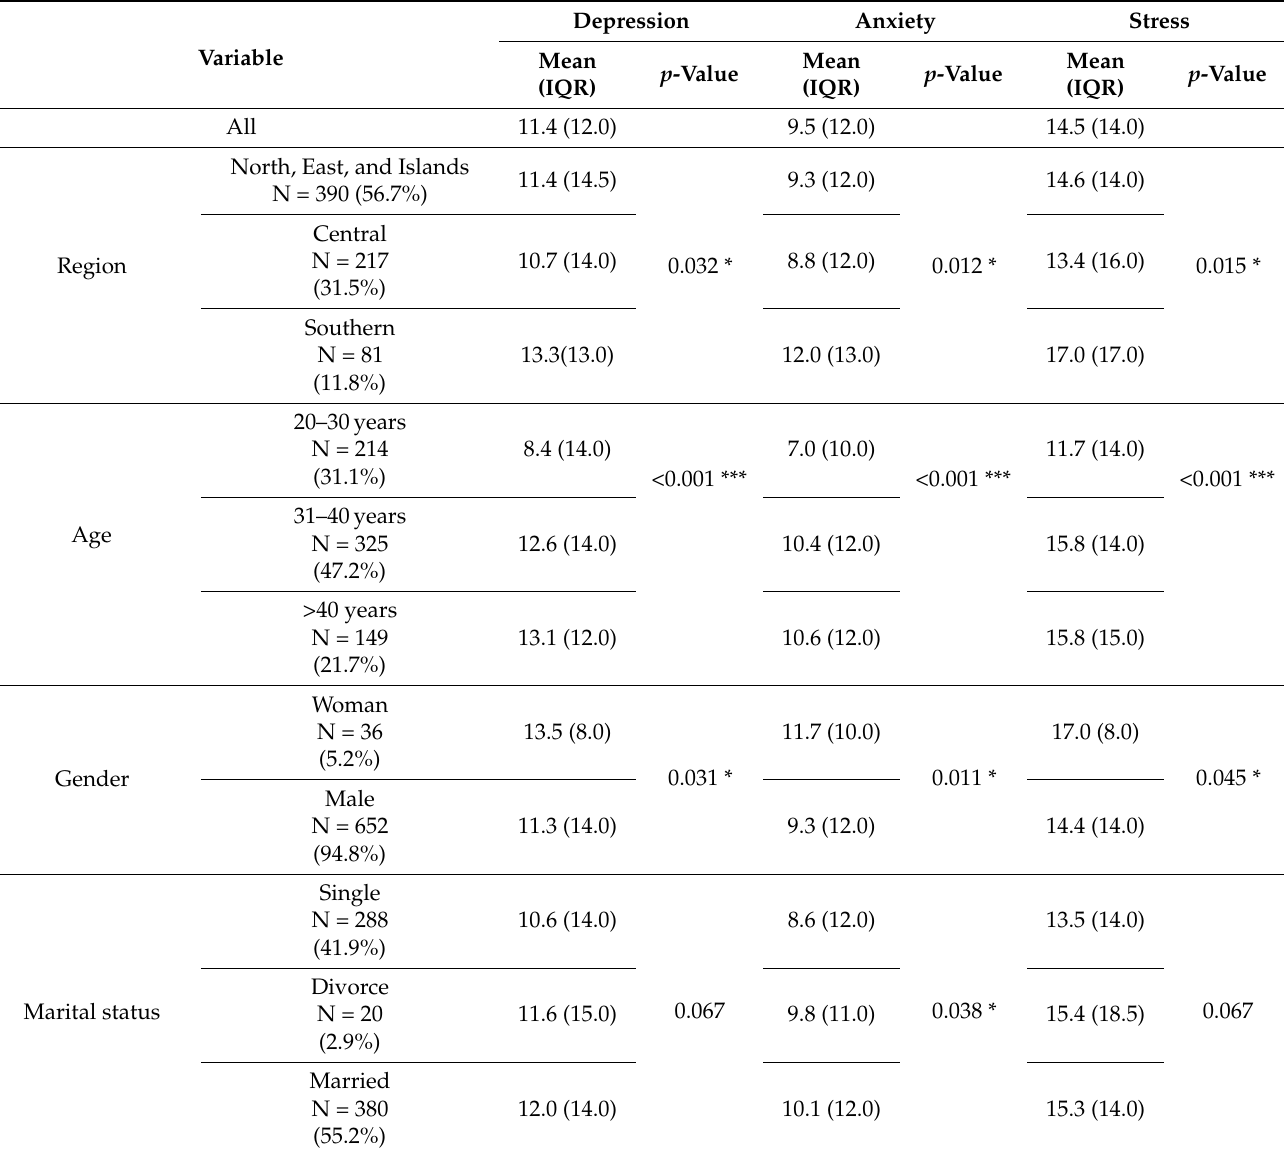
Table 1. Average scores for depression, anxiety, and stress based on demographic